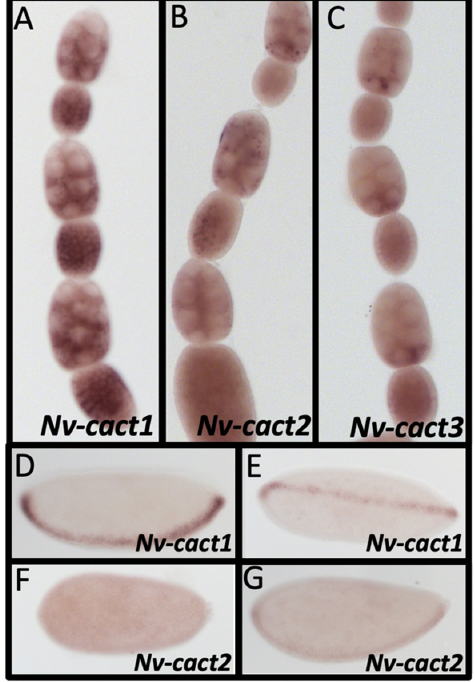
Figure 7. Expression of Nv-cact paralogs. ( A ) Nv-cact1 is expressed in the oocyte, follicle cells, and most of the nurse cell compartment throughout early, mid, and late oogenesis (early and mid stages shown). ( B ) Nv-cact2 is ubiquitously expressed in the oocyte and nurse cells throughout oogenesis (mid and late stages shown). ( C ) Nv-cact3 is ubiquitously expressed in the oocyte and nurse cells, with enhanced expression in posterior nurse cells (mid oogenesis stages shown). ( D , E ) In early blastoderm embryos, Nv-cact1 is expressed in a narrow stripe along the ventral midline ( D ) which remains throughout the late blastoderm stage ( E ). ( F , G) Nv-cact2 is initially expressed ubiquitously in the early blastoderm ( F ), before gaining elevated expression along the ventral midline in late oogenesis ( G ).